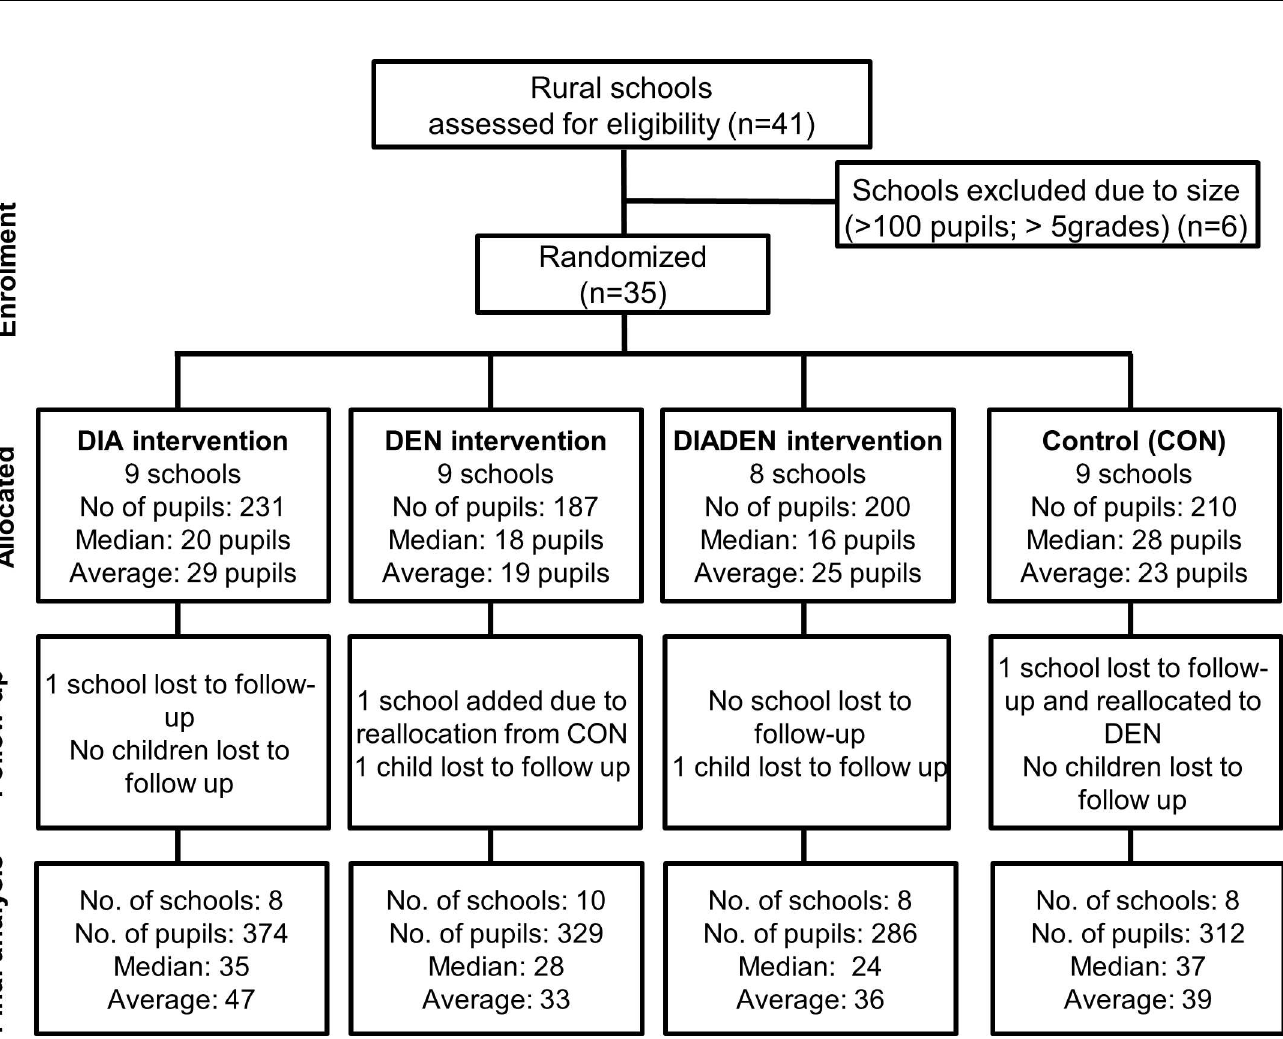
Fig 1. Flow diagram. Intervention assignment and follow-upanalysis of schools and pupils in La Mesa and Anapoima municipalities in Cundinamarca department,